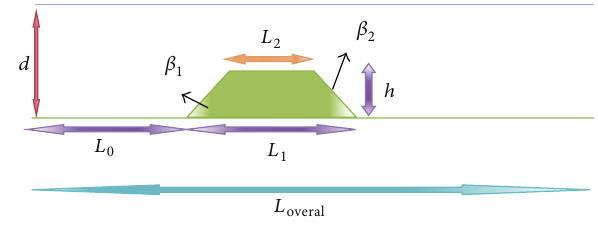
Figure 5: Computational domain.